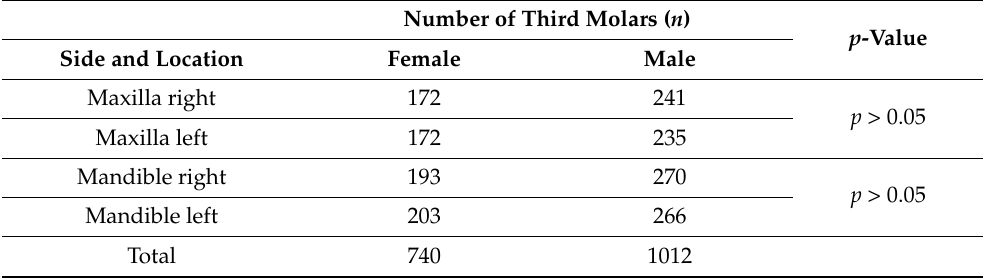
Table 4. Distribution of erupted, partially impacted, and completely impacted third molars according to gender. There is no significant difference between males and females ( p >